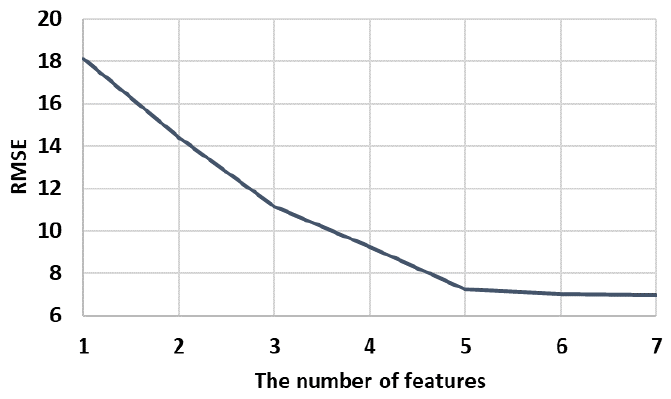
Figure 6. RMSE variation curve of different characteristic numbers.